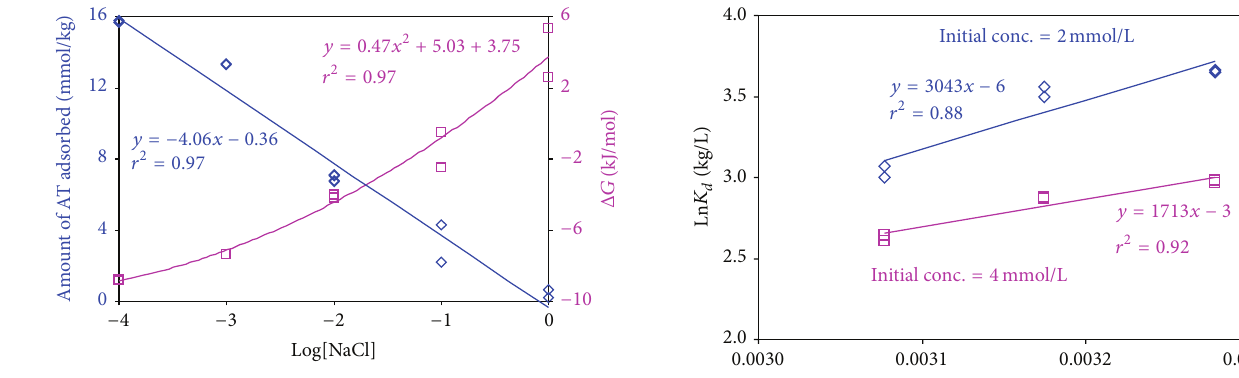
Figure 4: Influence of solution ionic strength on AT adsorption on kaolinite from 2 mmol/L solution and changes in free energies associated with AT adsorption.